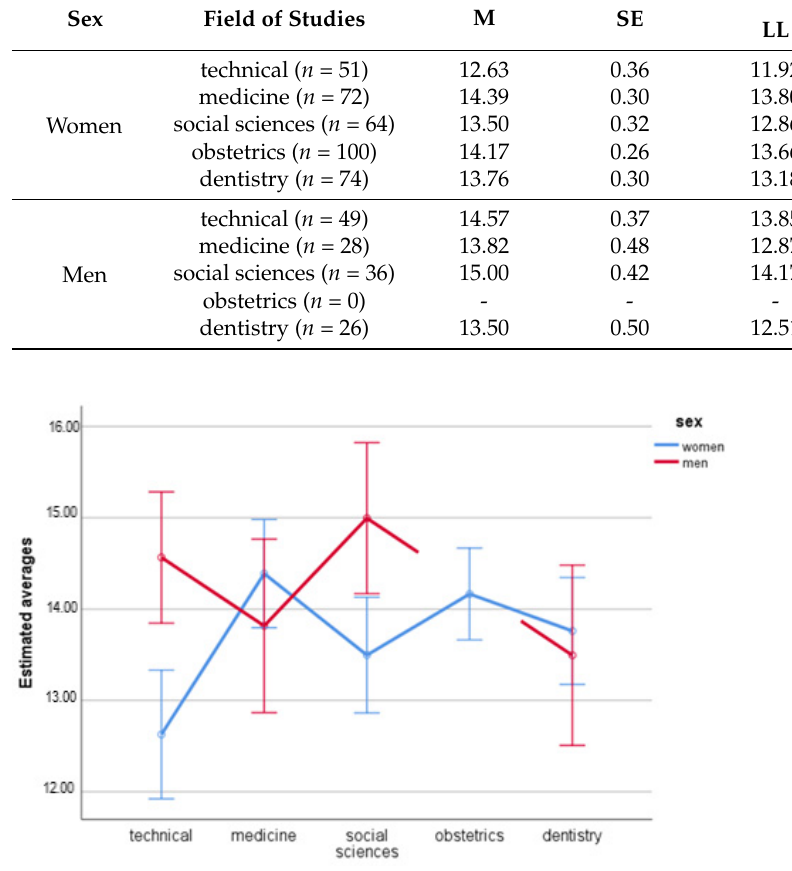
Figure 1. Estimated averages for first domain with regard to sex and field of